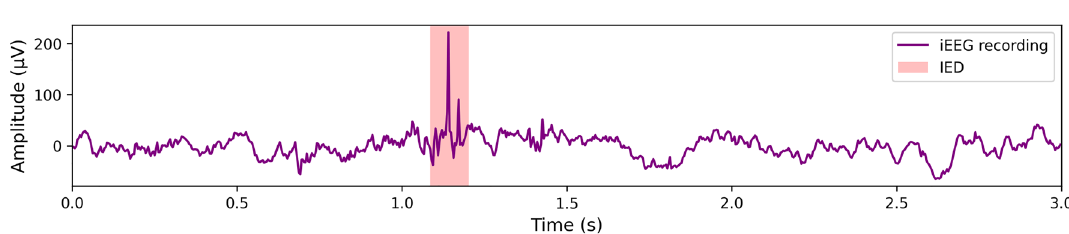
Figure 14. Intracranial recording from an electrode in the rostral anterior cingulate cortex of Subject 1 with an IED highlighted in